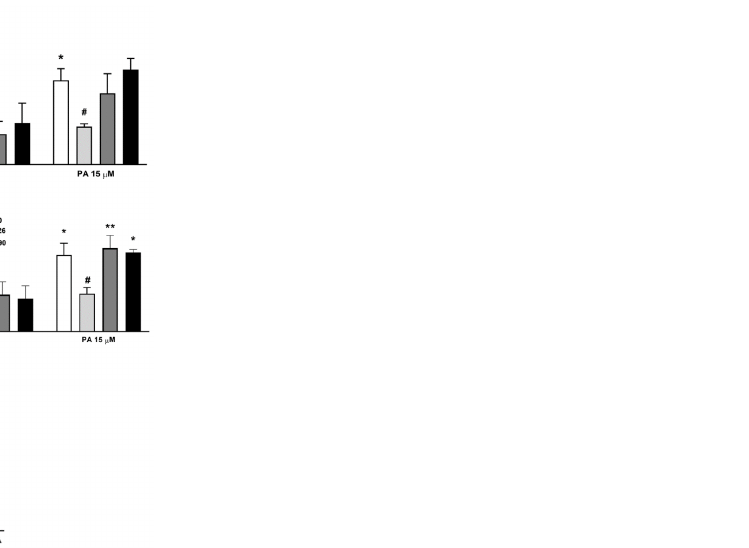
Figure 3. Involvement of MEK/ERK 1/2, but not p38 or JNK in PA-stimulated myoblast proliferation. Myoblasts were serum starved and maintained in DMEM supplemented with 0.1% BSA for 24 h before addition of agonists. ( A ) The cells were challenged with 15 µ M PA at the indicated time points. Cell lysates were analyzed by western blotting as described in the Materials and Methods section. Phosphorylation of ERK1/2 was determined with an antibody specific to phospho-ERK1/2. Equal loading of protein was monitored using a specific antibody to total ERK1/2. Panel A shows a representative blot of three independent experiments. ( B ) Results of scanning densitometry of the exposed film showing the p-ERK/total ERK ratio. Data are expressed relative to the control value without agonist and are the mean ± SEM of 3 independent experiments performed in triplicate. (*** p < 0.001). ( C ) C2C12 cells were preincubated for 30 min with 10 µ M PD98059 to inhibit MEK, 5 µ M SB239063 to inhibit p38 or 1 µ M SP600125 to inhibit JNK, and were then treated with 15 µ M PA, or vehicle for 16 h. [ 3 H]Thymidine incorporation was measured as described in the Materials and Methods section. Results are expressed relative to the control value without agonist and are the mean ± SEM of 3 independent experiments performed in triplicate. (* p < 0.05, control versus PA-treated cells, # p < 0.05; PA-treated cells versus PA-treated cells in the presence of the inhibitor). ( D ) Cells were treated as in panel C. Cell proliferation was determined by staining the myoblasts with crystal violet as described in the Materials and Methods section. Results are expressed relative to the control value without agonist and are the mean ± SEM of 3 independent experiments performed in triplicate. (* p < 0.05, control versus PA-treated cells, # p < 0.05; PA-treated cells versus PA-treated cells in the presence of the inhibitor); ** p < 0.01, control versus PA-treated cells in the presence of SP600126; p < 0.05, control versus PA-treated cells in the presence of SB202190. ( E ) C2C12 cells were pre-treated for 5 h with negative (scrambled) siRNA, or with specific ERK1 or ERK2 siRNA (40 nM in all cases), prior to stimulation with 15 µ M PA, as indicated. [ 3 H]Thymidine incorporation was measured as described in the Materials and Methods section. Results are expressed relative to the control value without agonist and are the mean ± SEM of 3 independent experiments performed in triplicate. (* p < 0.05, control versus PA-treated cells, # p < 0.05; PA-treated cells versus PA-treated cells in the presence of the corresponding